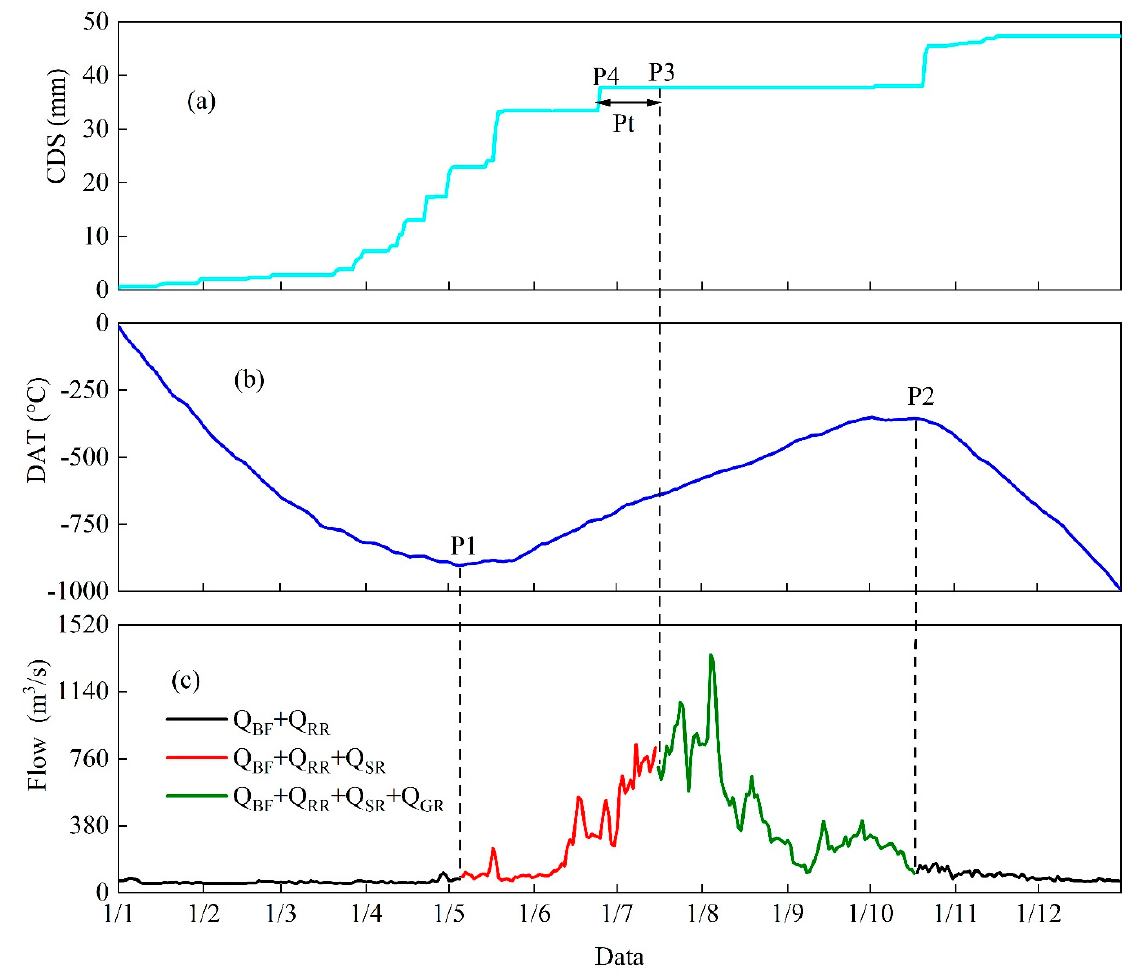
Figure 2. ( a ) Cumulative curve of daily snowfall (CDS). ( b ) Daily accumulated temperature curve (DAT). ( c ) Hydrograph partitioning curves (HPC). Q BF + Q RR represents the baseflow, and rainfall dominates this hydrograph part. Q BF + Q RR + Q SR refers to the baseflow, rainfall, and snowmelt dominating the hydrograph. Q BF + Q RR + Q SR + Q GR refers to the hydrograph part controlled by baseflow, rainfall, snowmelt, and glacier melt.